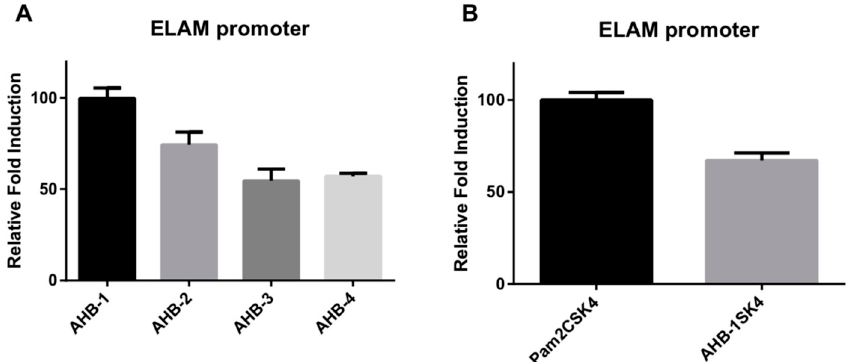
Figure 2. TLR2 and TLR6 activation by N -acetyl Pam 2 Cys and analogues. HEK293 cells were transfected with plasmids encoding TLR2, TLR6 and the ELAM-SEAP reporter. After 24 h, cells were treated with 1 µ M of indicated compounds for 6h. SEAP activities were measured by spectrophometer (OD 412 ). The data shown are representative of three independent experiments. ( A ) TLR2 and TLR6 activation studies using synthetic compounds AHBs; ( B ) Comparison of TLR2 and TLR6 activation via AHB-1SK 4 and Pam 2 CysSK 4.